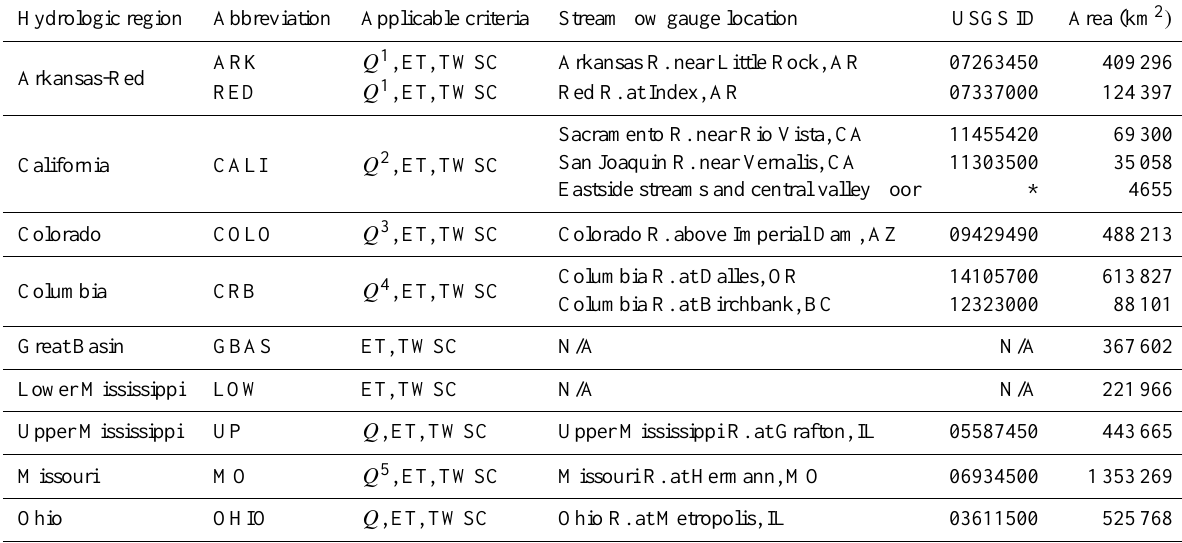
Table 1. Major hydrologic regions considered in this study including streamflow gauges and drainage areas.